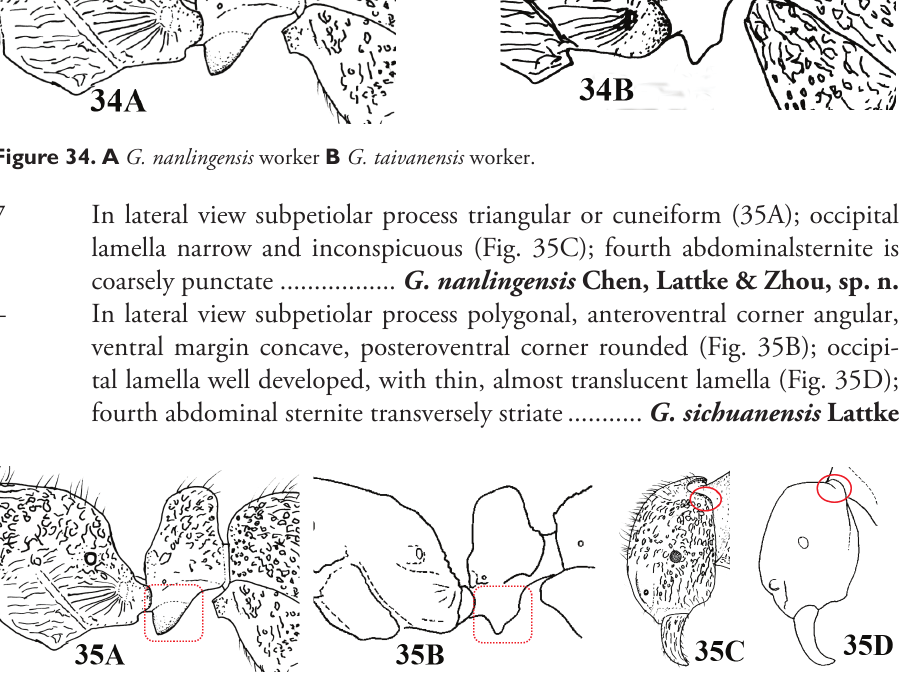
Figure 35. A, C G. nanlingensis worker B, D G. sichuanensis worker (Cited from Lattke, 2004) . 8 Eye medium-sized, with 7 ommatidia on maximum diameter; declivity trans-